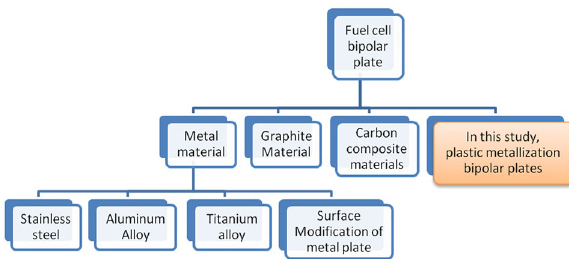
Figure 3. Species of bipolar plates.